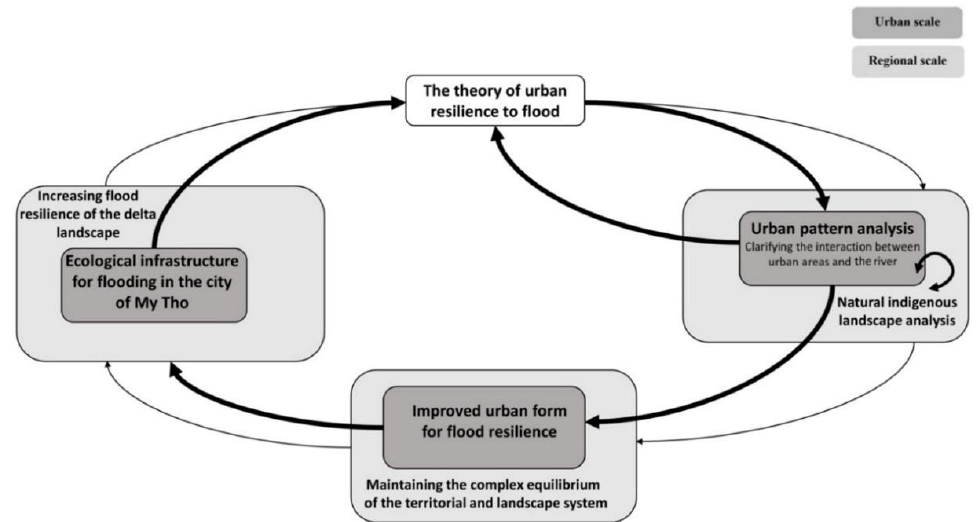
Figure 4. The capacity-based resilience of ecological infrastructure will play a core role in urban flood management. In particular, the cross-scale interactions of the components in the urban ecosystem will contribute to improving urban resilience to floods.